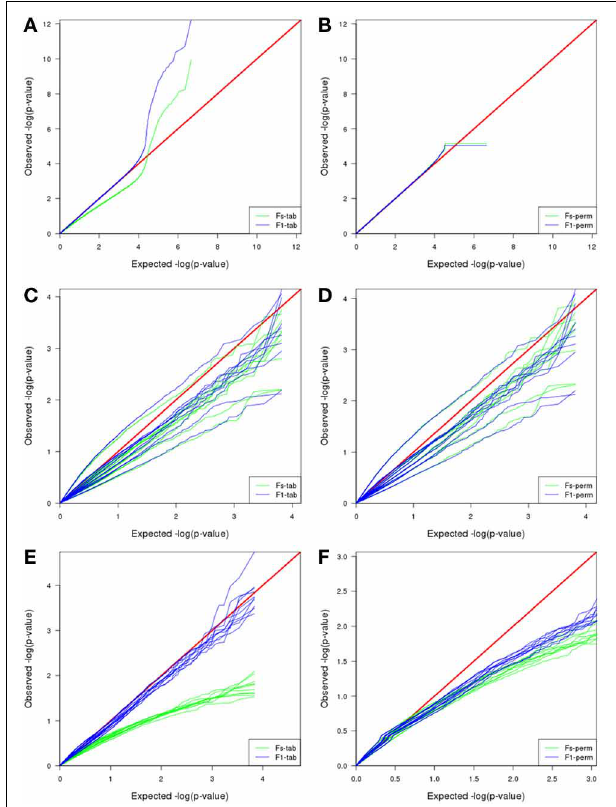
FIGURE 8 | Comparison of MAANOVA’s p -value results of non-differentially expressed transcripts using F s moderated test and F1 transcript by transcript test, with a tabulated (left) or permutation (right) approach. In the simulated dataset (A,B) the permutation approach presented a more characteristic uniform distribution, the plateau at the end is caused by the replacement of zeroes by the minimum observed p -value when computing logarithm. Plasmodes generated from Cheung dataset, presented similar patterns either using a tabulated or a permutation approach (C,D) . Plasmodes generated from Bottomly presented better patterns for F s with permutation and F1 with tabulated approach (E,F)